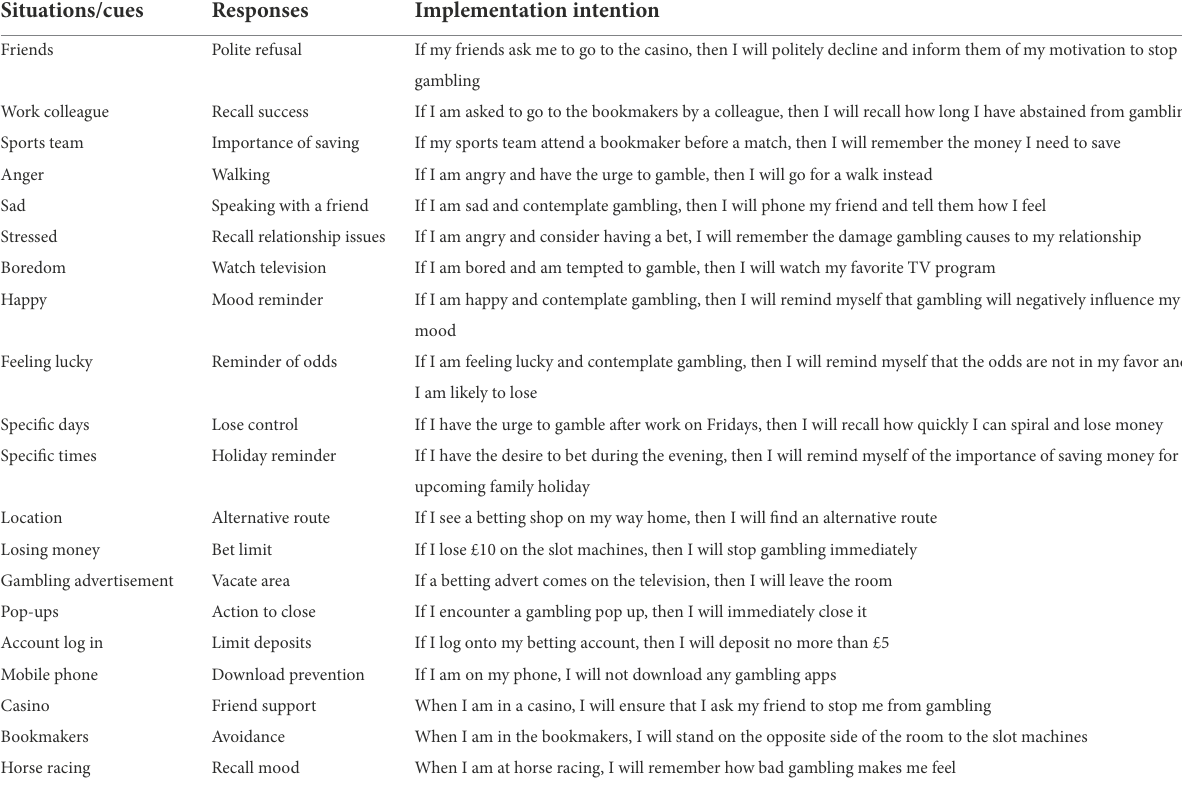
TABLE 1 Examples of situations, responses, and implementation intentions related to gambling